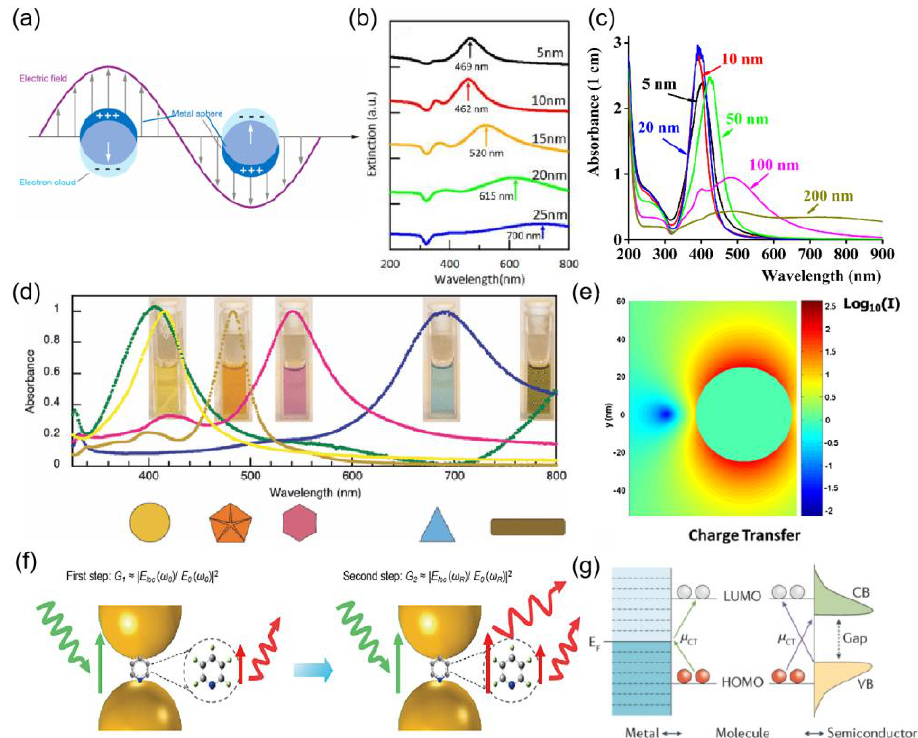
Figure 1. ( a ) interaction of a light wave with a spherical metallic NP causing oscillation of the electron cloud on the surface of the NP. ( b ) Extinction spectra of the Ag NPs fabricated from the different initial Ag deposition thickness. The main peak position of the extinction was indicated by the arrow. Reprinted with permission from Ref. [22]. Copyright 2021, Vacuum. ( c ) Absorbance spectra of the Ag NP of 5 nm (solid black line), 10 nm (solid red line), 20 nm (solid blue line), 50 nm (solid green line), 100 nm (solid magenta line), and 200 nm (solid olive line). Reprinted with permission from Ref. [23]. Copyright 2016, Optical Materials. ( d ) Absorption spectra for the corresponding morphologies that can be generated with the LED irradiation approach from a single precursor solution of 3 nm silver seeds. Reprinted with permission from Ref. [24]. Copyright 2012, Photochemistry and photobiology. ( e ) near-field intensity distribution around a single silver nanoparticle. Reprinted with permission from Ref. [25]. Copyright 2016, Advances in Physics. ( f ) Electromagnetic (EM) enhancement mechanism in SERS, including the two-step enhancements, illustrated in the nanogap of two metal nanoparticles. Reprinted with permission from Ref. [31]. Copyright 2018, Chemical Reviews. ( g ) Chemical enhancement through charge transfer (CT) between metal/semiconductor and the adsorbed molecule. The CT transitions ( μ CT) arrows show the CT directions. Red and white circles represent molecular orbitals. CB, conduction band; EF, Fermi level; HOMO, highest occupied molecular orbital; LUMO, lowest unoccupied molecular orbital; VB, valence band. Reprinted with permission from Ref. [31]. Copyright 2018, Chemical Reviews.